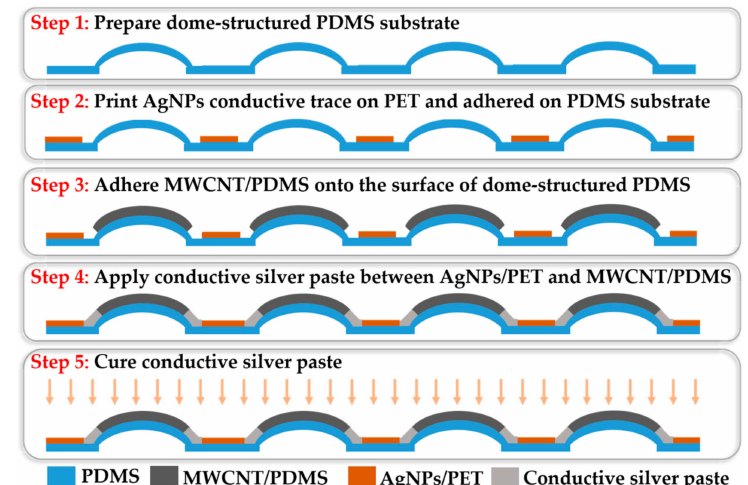
Figure 3. The integration steps of the flexible tactile sensor array.